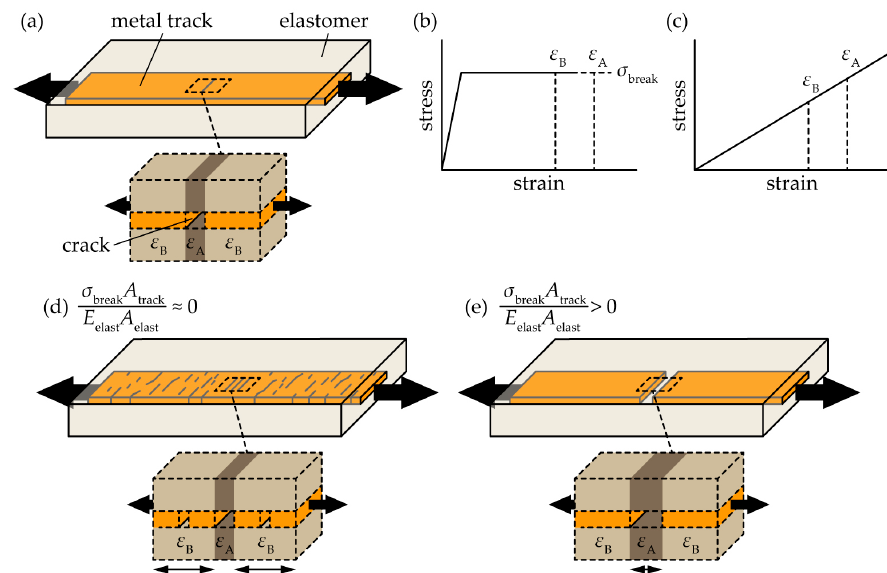
Figure 1. Schematic of the crack ‐ configuration modeling analysis. ( a ) Cracked metal track embedded in a stretchable elastomer; ( b ) simplified stress ‐ strain curve of a metal track layer; ( c ) simplified stress strain ‐ curve of a stretchable elastomer; ( d ) schematic of a multiple ‐ crack growth type; and, ( e ) schematic of a single ‐ crack growth type.